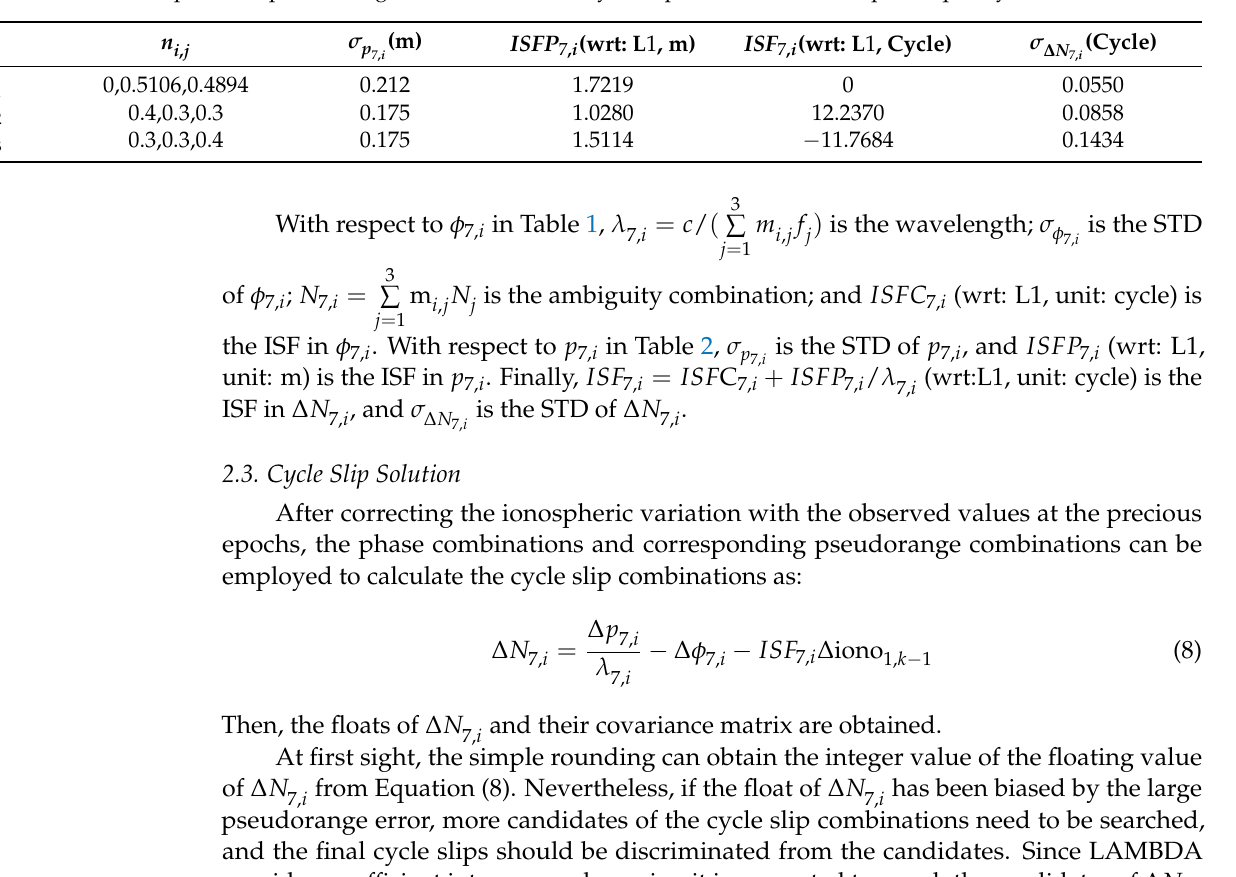
Table 2. The optimized pseudorange combinations and cycle slip combinations of triple-frequency